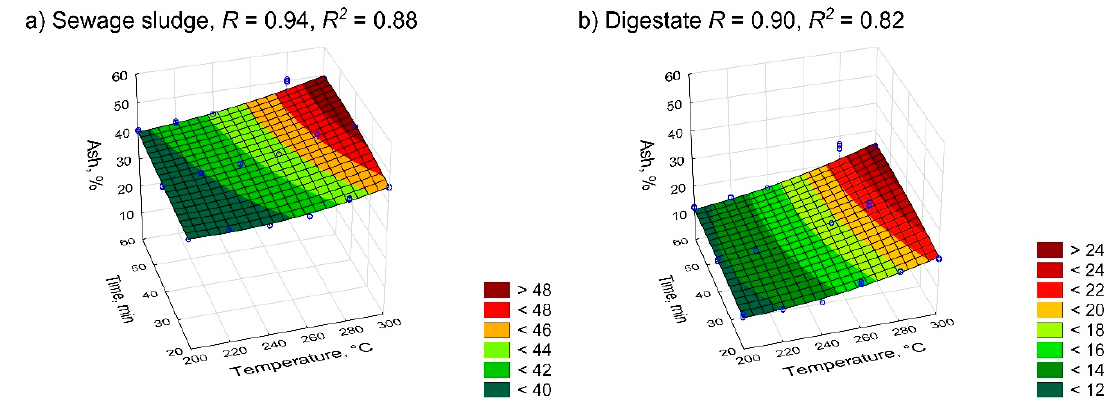
Figure 8. The influence of torrefaction temperature and residence time on ash content in CSF from ( a ) sewage sludge and ( b ) digestate. R —correlation coefficient; R 2 —determination coefficient.